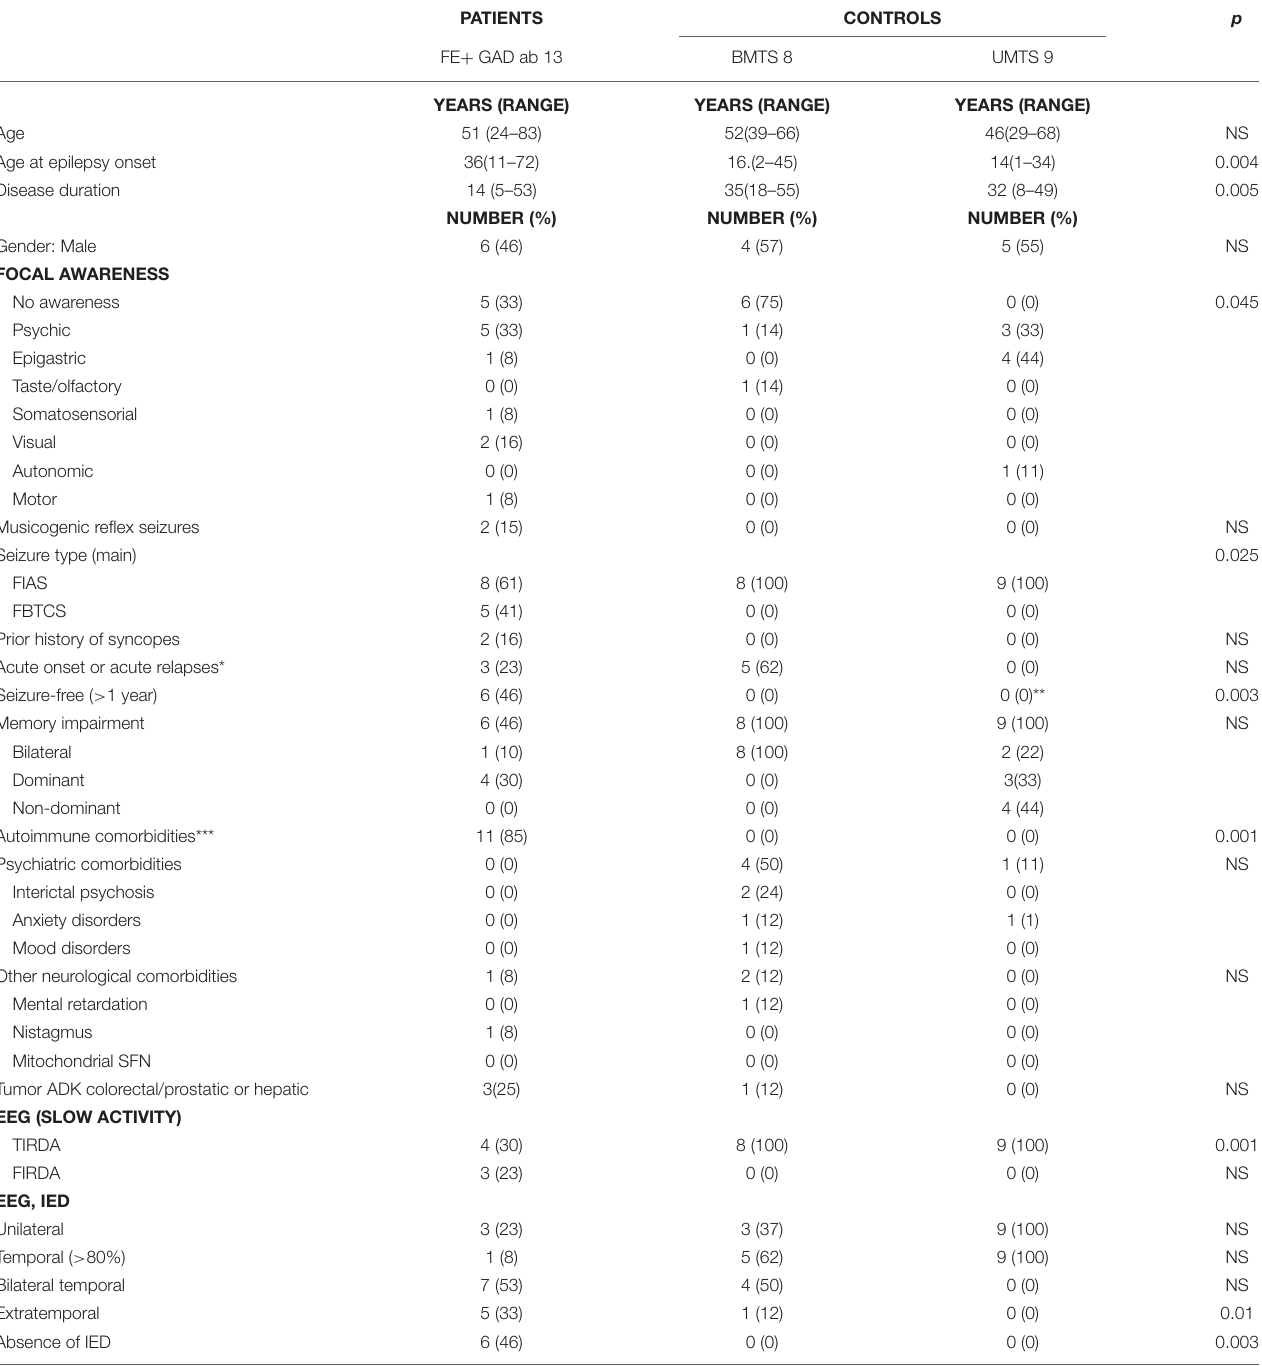
TABLE 1 | Patients and